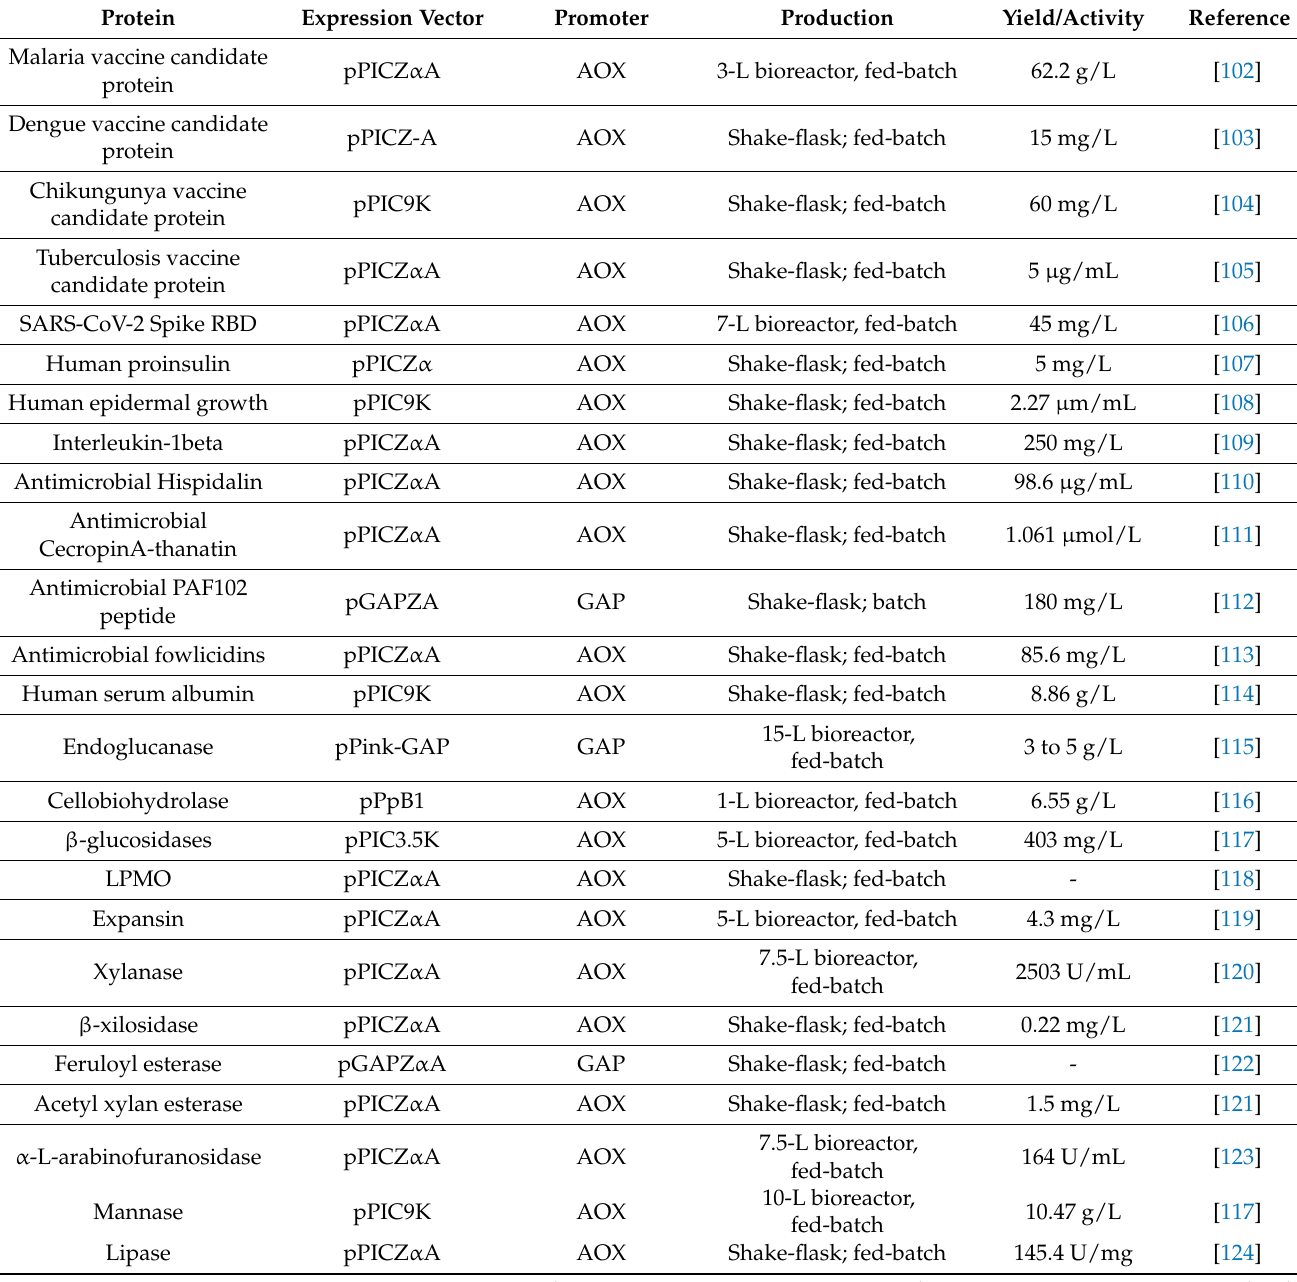
Table 4. Examples of heterologous proteins expressed in K. phaffii and production